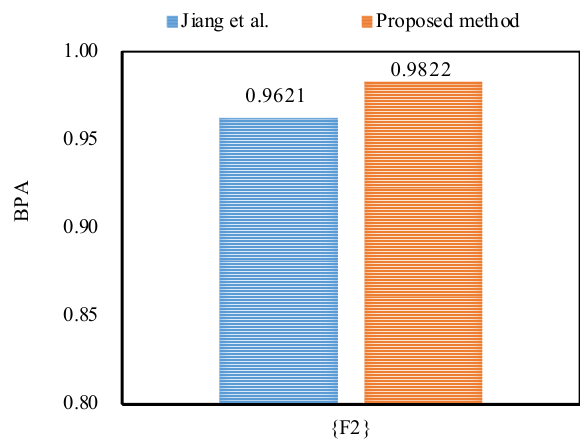
Figure 6. The comparison of the BPA of the target F 2 at 2 X frequency.